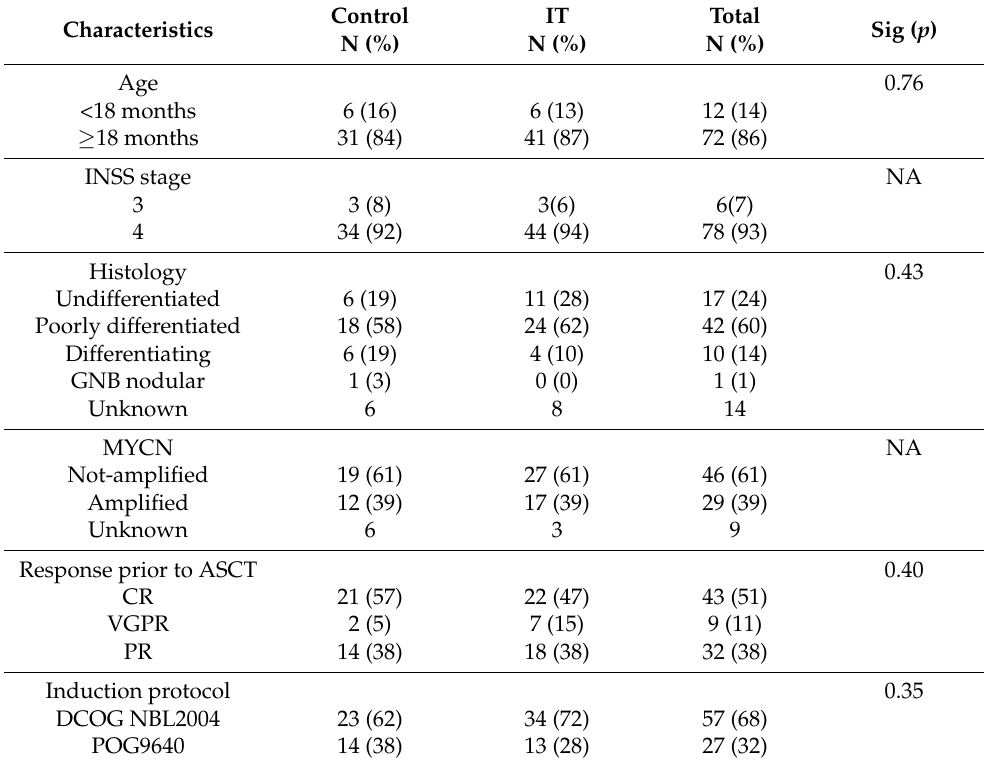
Table 1. Patient